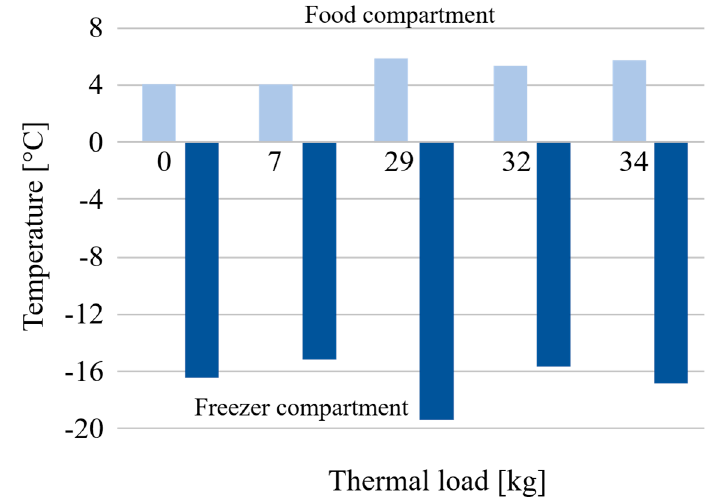
Figure 3. Thermal behavior of the compartments at 20 °C.